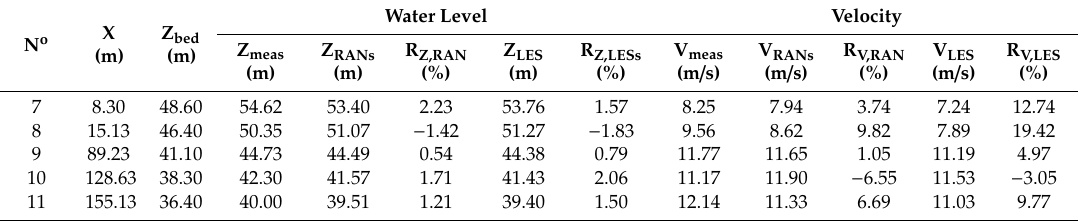
Table 2. Water elevation and velocity in case 1.